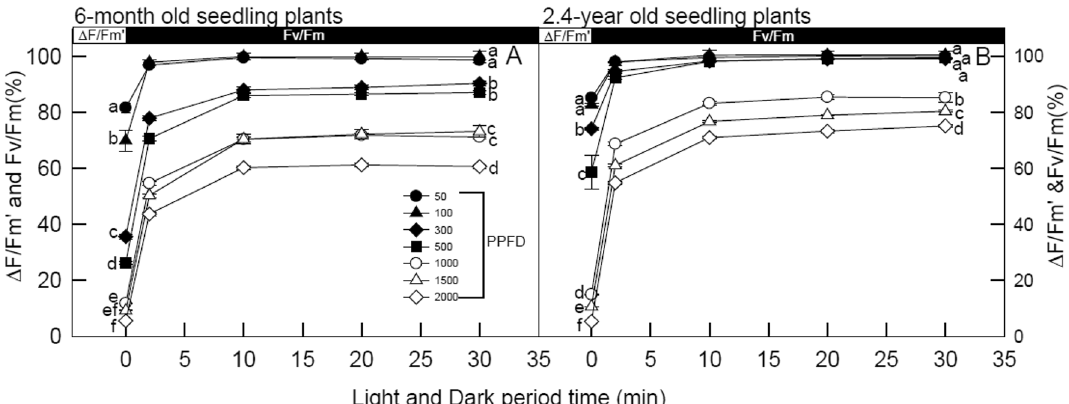
Fig. 2 Relative value of actual PSII efficiency (ΔF/F’m) and potential quantum efficiency of PSII (Fv/Fm; Fv/Fm value of the same leaves before illumination set as 100%) obtained at artificial illumination of 60 min and subsequent dark recovery for 30 min (2 ~ 30 min dark) for 6‑month (panel A ) and 2.4‑year (panel B ) seedlings of Mahonia oiwakensis under 50, 100, 300, 500, 1,000, 1,500, and 2,000 μmol m − 2 s. − 1 PPFD at 25 °C. Vertical bars indicate standard errors, and each point represents the mean of 5 leaves. Different letters indicate significant differences in Tukey’s HSD analyses for seven LI treatments ( p < 0.05)